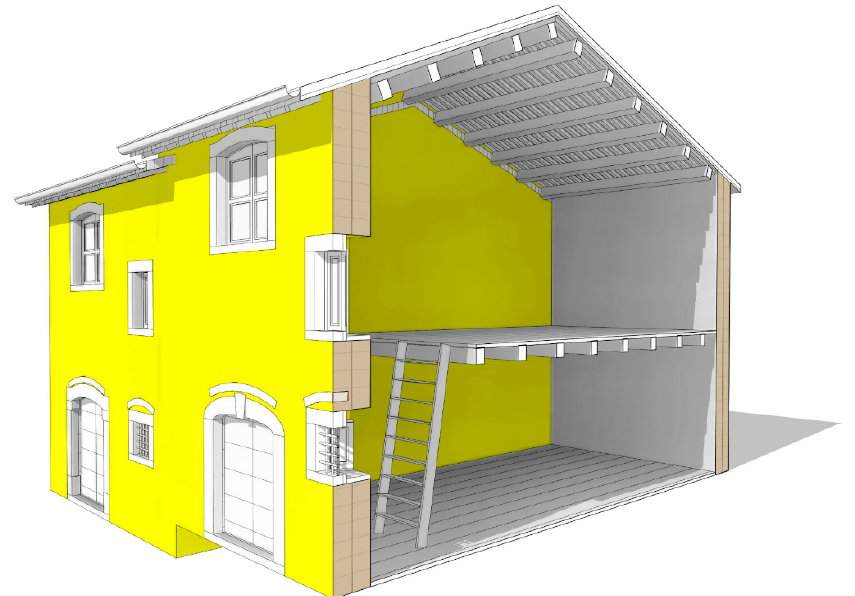
Figure 15. Properties of a wall in the IQM Revit Template, with the IQM parameters (input—red) filled in by the IQM operator and the automatically returned IQM category values (output—blue), applied to a case study building in the historic centre of Cornillo Nuovo—SISMI project [41].